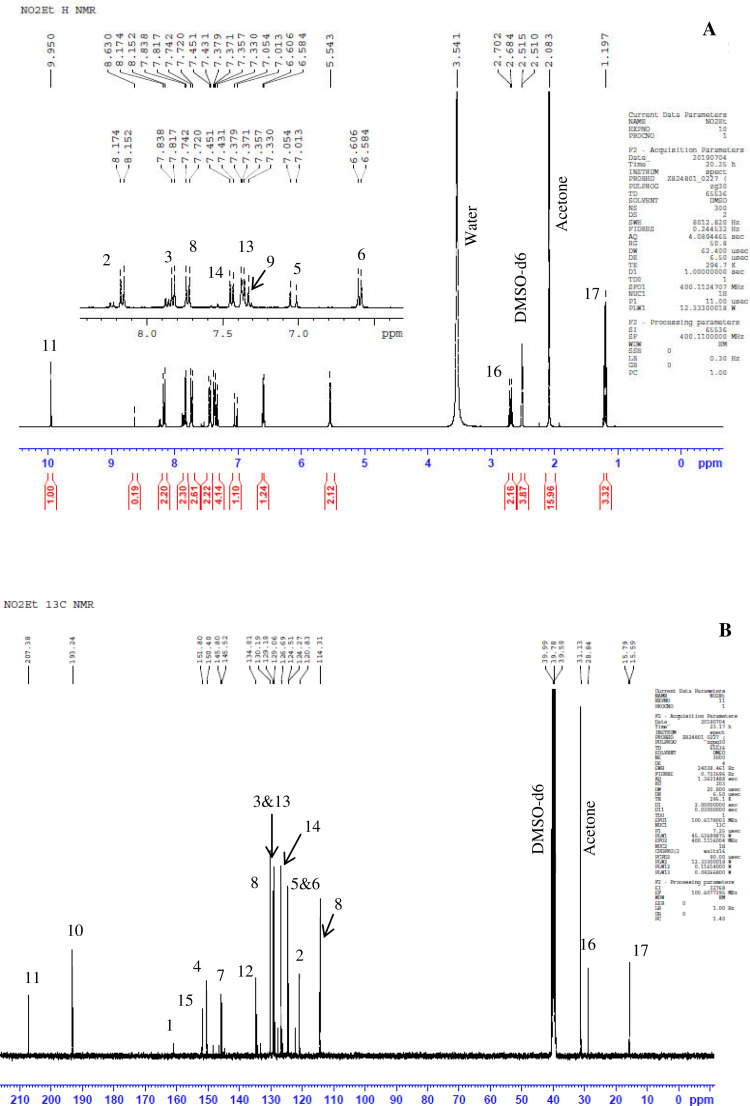
(A) 1H and (B) 13C NMR of NO2Et.